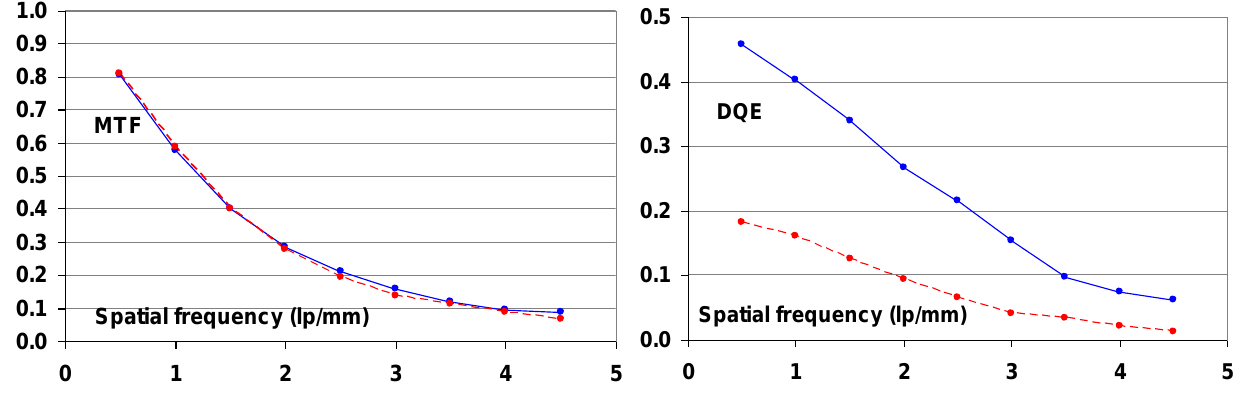
Figure 38. Ratio of NIP DQE to PIP DQE in DX-G  . RQA 5 exposure and 2.5 μGy